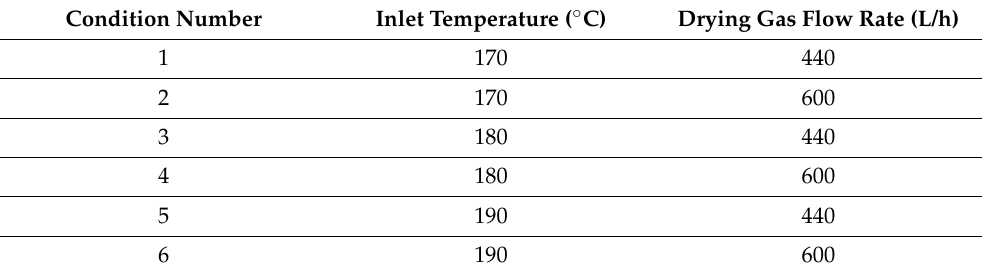
Table 1. Experimental conditions for the preparation of CMC.BTA-MS by spray drying. Condition Number Inlet Temperature ( ◦ C) Drying Gas Flow Rate